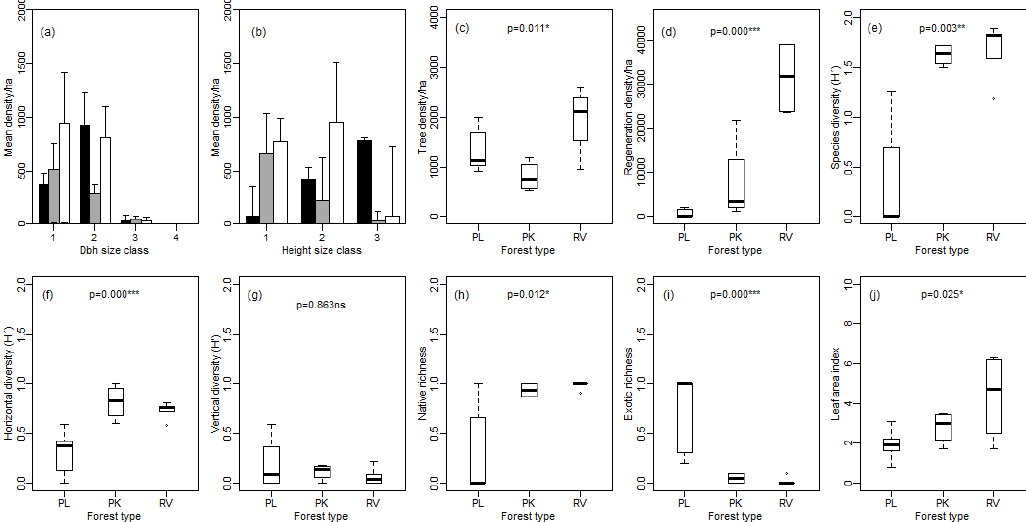
Figure 2. ( a , b ) The forest structure of the three forest types: Eucalyptus plantations (black bars), park forests (dark grey bars) and riverine forests (white bars): expresed as mean tree density per ha in diameter classes (1 = 2.5–10 cm, 2 = 10–30 cm, 3= 30–50 cm, 4 = >50 cm) and height size classes (1 = 0–5